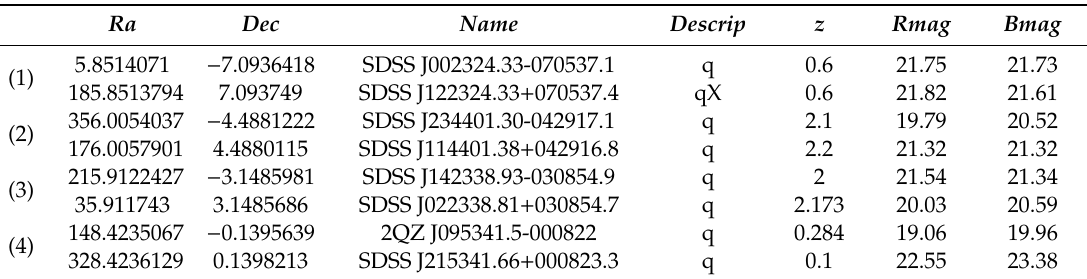
Table 13. Pairs of opposite quasars with the best accuracy in position and redshift found in Milliquas 6.3 catalog as candidate pairs for cosmic mirror e ff ect. Accuracy is of 0.0005 ◦ for ra and dec and 0.2 for z . Descrip column is the classification of object, see [47].